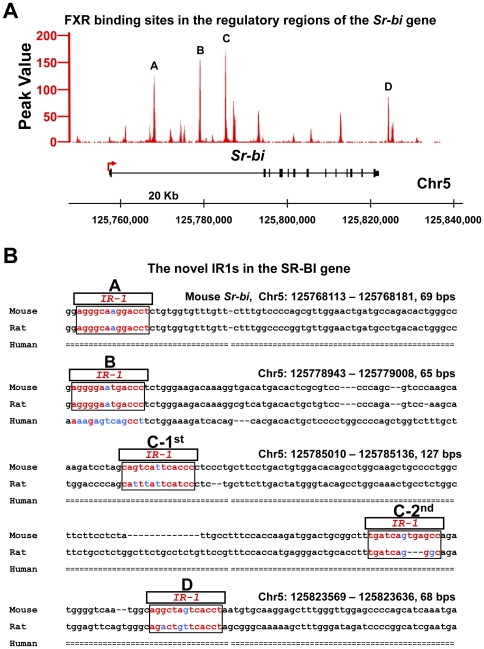
Novel FXR response elements, IR1s, in the first intron and downstream of the mouse Sr-bi gene.
A, The novel four FXR binding sites (A, B, C, and D) in the Sr-bi gene identified by ChIP-seq analysis. B, The novel IR1s (A, B, C-1st, C-2nd and D) identified at the first intron and downstream of the Sr-bi gene are conserved within mouse and rat, but not human, Sr-bi/SR-BI gene. The novel IR1s are marked in the box.